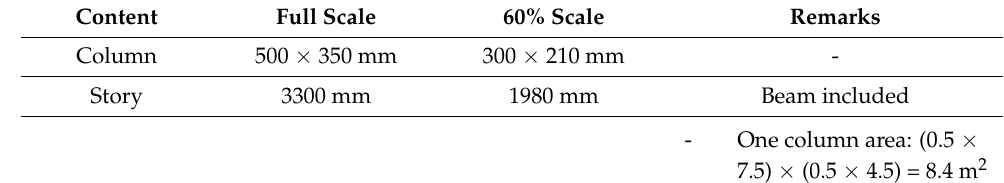
Figure 5. Plan view of the school building with the section used for testing shown in the dashed outline.